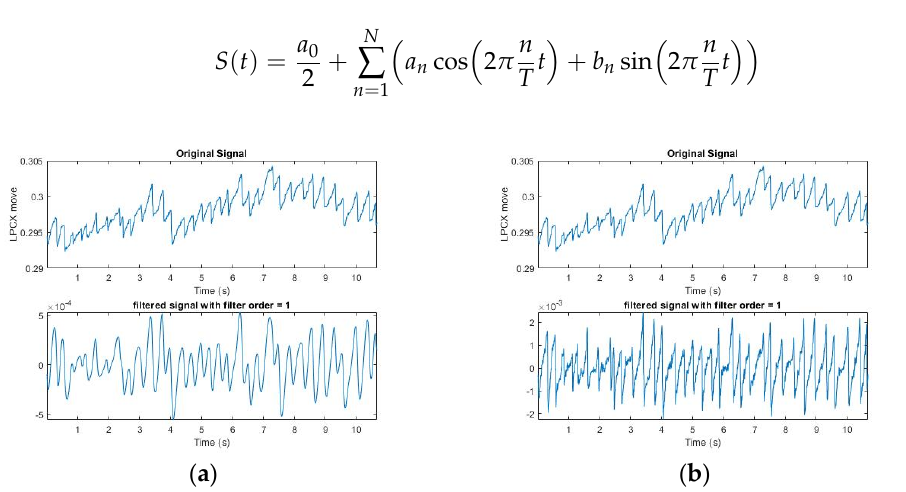
Figure 9. ( a ) The lower part represents the signal after the band pass; ( b ) the lower part represents the signal after the high pass. It was easier to mark the position of FP with the results of the high pass, but the set threshold was difficult to fully meet the conditions.